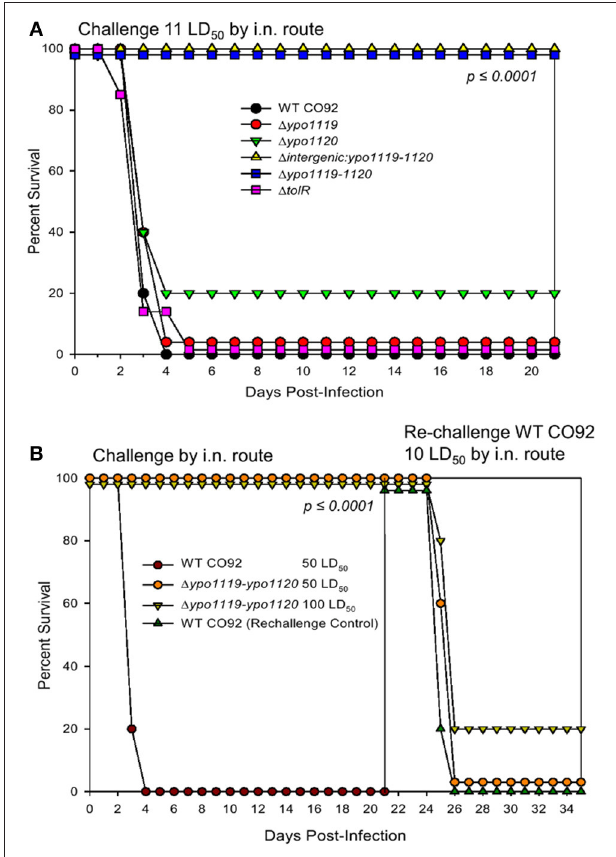
FIGURE 2 | Contribution of Tol operon - associated genes in the virulence of Y. pestis CO92 in a mouse model of pneumonic plague. (A) Female Swiss-Webster mice were challenged by the i.n. route with 11 LD 50 of WT Y. pestis CO92 or the indicated deletion mutant strains ( n = 10). Animals were observed for morbidity/mortality for 21 days p.i. (B) Mice were challenged by the i.n. route with the WT CO92 or the 1 ypo1119-1120 deletion mutant ( n = 10) at the indicated LD 50 doses and then observed for morbidity/mortality over a period of 21 days. Mice that survived the initial infection with the mutant strain ( n = 10) and naive control animals ( n = 5) were challenged with 10 LD 50 of the WT CO92 strain and monitored for 14 days p.i. Survival data were analyzed for significance by Kaplan–Meier survival estimates. Two independent experiments were performed and the data from the second set constituting a group size of 10 animals/group were